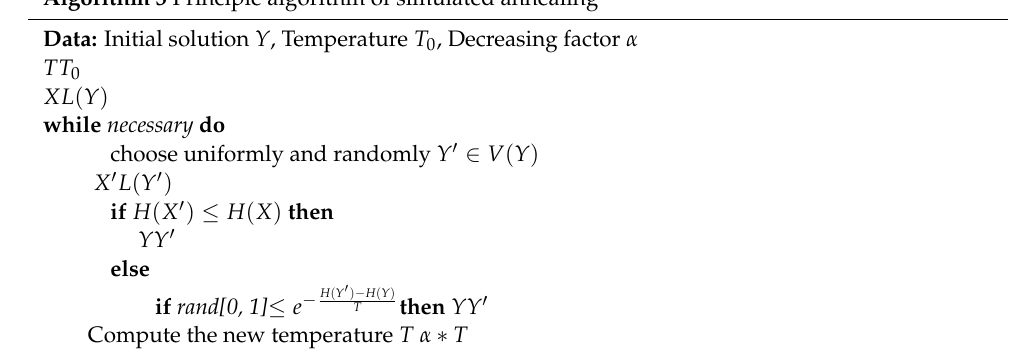
Algorithm 3 Principle algorithm of simulated